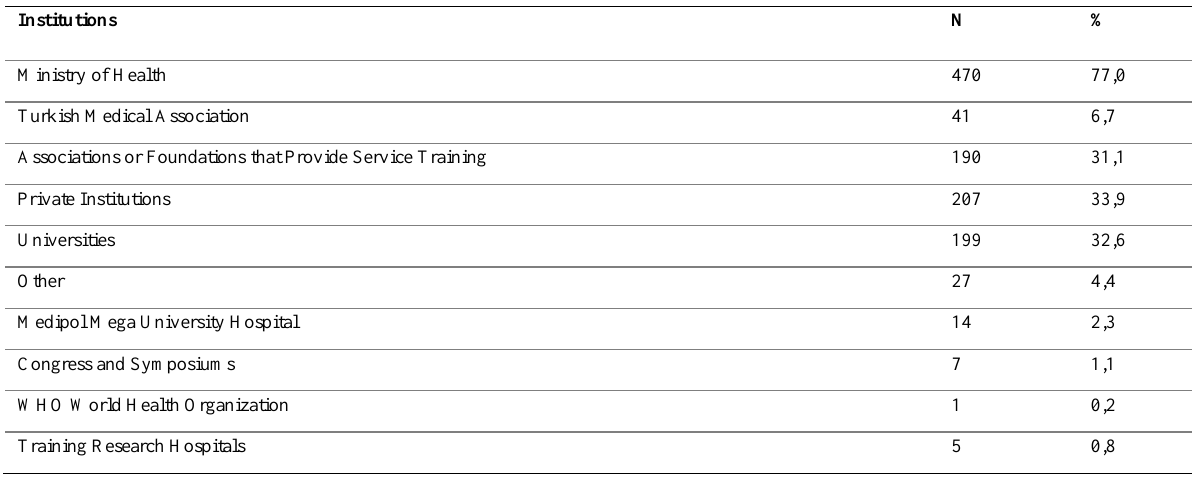
Table 11: Institutions where the Trainings were